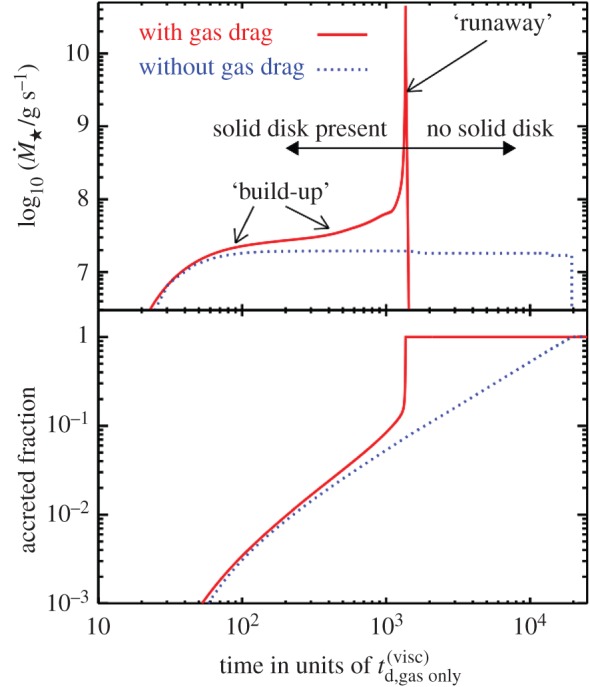
Cosmetically enhanced version of fig. 7 of [296]. How a coupled gas and dust WD debris disc becomes a ‘runaway’ disc, which features a burst of accretion at the inner rim. The difference in the dotted blue and solid red lines illustrates the importance of including coupling in WD debris disc models.